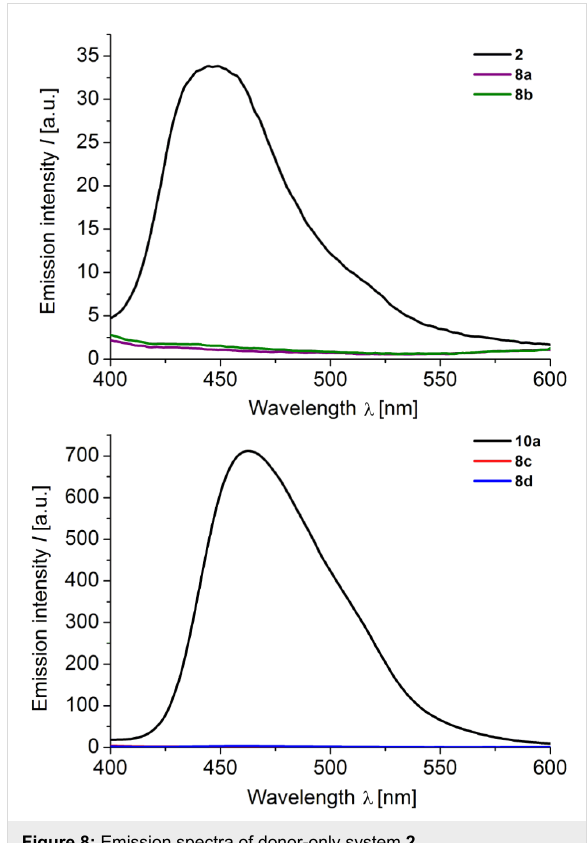
Figure 8: Emission spectra of donor-only system 2 phenothiazine–anthraquinone dyads 8a , b (top), and the donor-only system 10a and the phenothiazine–anthraquinone dyads 8c , d (bottom) (recorded in CH 2 Cl 2 , T = 298 K, c = 0.7–2.9 ∙ 10 − 6 mol·L − 1